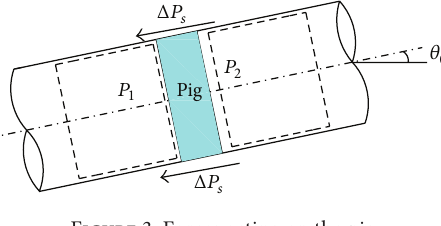
Figure 3: Forces acting on the pig. Table 1: Summary of basic parameters for field operations.